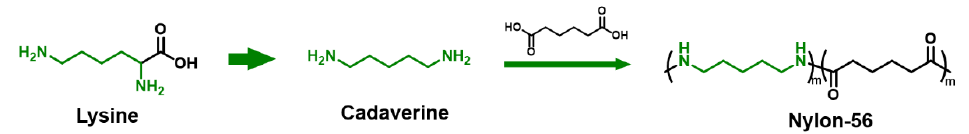
Figure 9. Production process of bio-based nylon-56.